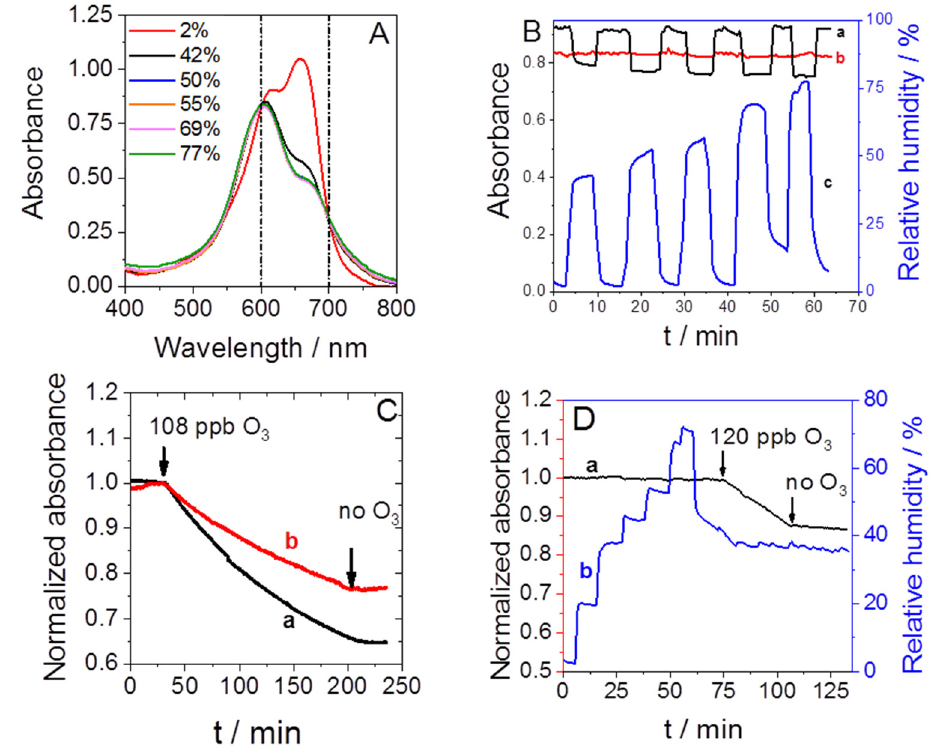
Figure 3. ( A ) Absorbance of methylene blue in the mesoporous silica in the presence of 2%, 42%, 50%, 55%, 69%, and 77% relative humidity in air. ( B ) Absorbance of methylene blue in the mesoporous silica measured as a function of time at 620 nm (a, black) and 600 nm (b, red) while the relative humidity varied from 2% to 77% (c, blue). ( C ) Variation of the normalized absorbance in the presence of 108 ppb O 3 as a function of time in air with 1% (a) or 40% RH (b). ( D ) Sensor response as a function of time, relative humidity, and O 3 concentration in air (a), and the amplitude of the relative humidity variation as a function of time during the experiment (b).